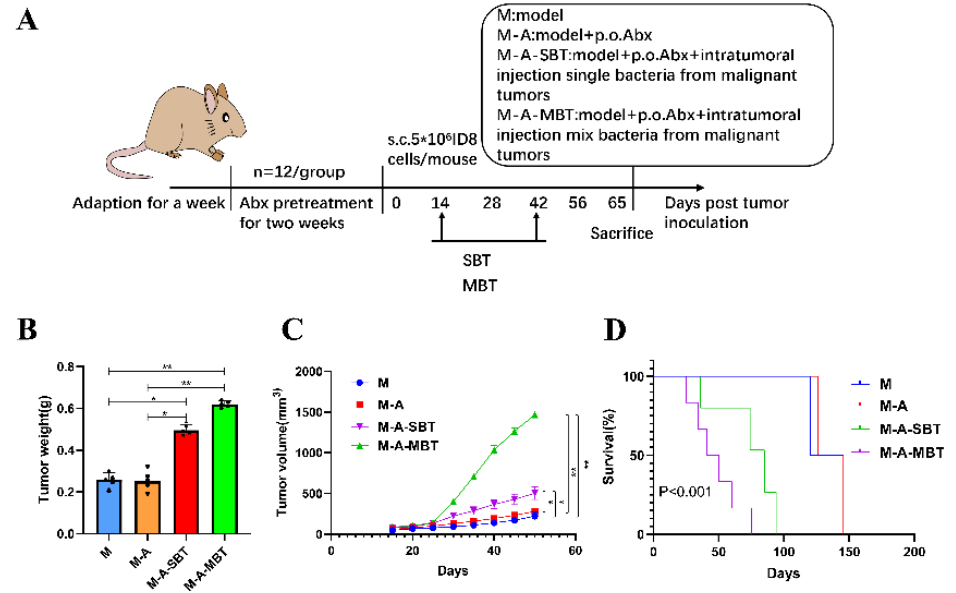
Figure 4. Injecting intratumourally with P. acnes from EOC can promote tumour growth and reduce tumour model survival as well as mixed bacteria from EOC. ( A ) Scheme of the animal experiment. ( B ) Changes in tumour volume over time in different treatment groups. ( C ) Final tumour weights in different treatment groups. ( D ) Kaplan–Meier survival curves of mouse EOC models in different treatment groups. Data are presented as means ± SD. Two-way repeated measures ANOVA, both with Tukey’s test for multiple comparisons, ( B ) and ( C ), respectively, and log-rank test were performed for survival data ( D ); * p < 0.05, ** p < 0.01.